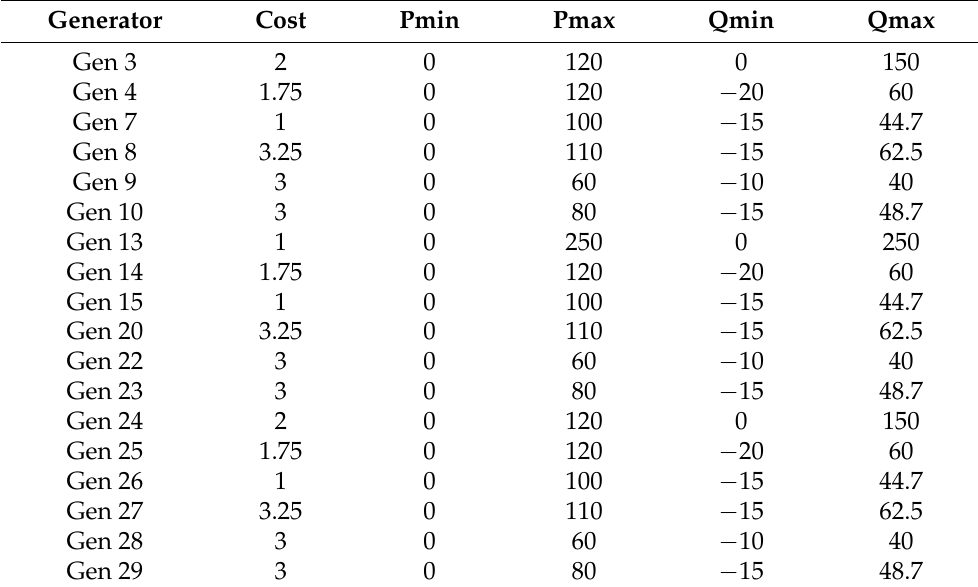
Table 3. Generation